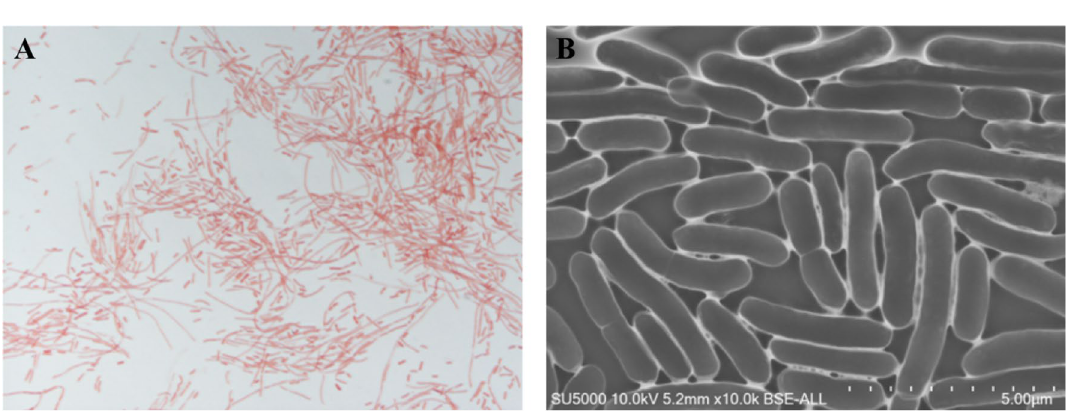
Figure 3. Micrograph of Marseille-P9602 strain. (A) Micrograph of Marseille-P9602 strain after Gram staining, (B) Transmission electron microscopy micrograph of Marseille-P9602